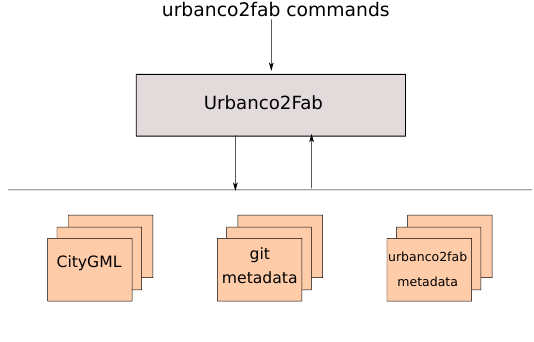
Figure 5. UrbanCo2Fab: Using urbanco2fab commands